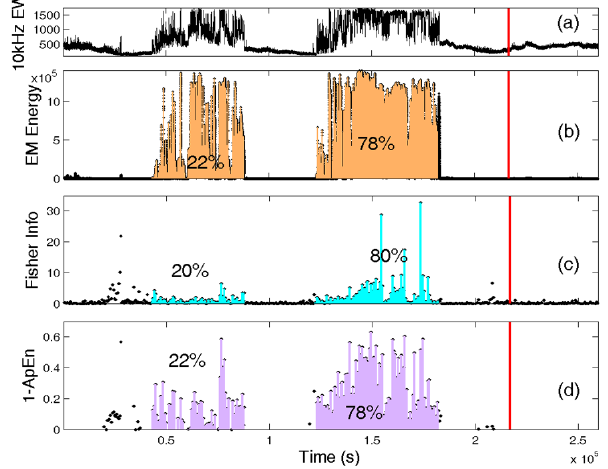
Fig. 2. (a) The two strong impulsive bursts in the tail of the recorded pre-seismic kHz EM emission prior to the Athens (Greece) EQ ( M = 5 . 9) that occurred on 7 September 1999 (please refer to Fig. 1 in Papadimitriou et al., 2008). For the specific signal excerpt, the EM energy (b) , the Fisher information (c) , and approximate en- tropy (d) evolutions with time are presented. The colored areas indi- cate the energy, information, and 1-ApEn corresponding to the two bursts. The first (left) burst is responsible for 22% of the EM en- ergy, 20% of the Fisher information, and 22% of the ApEn, while the second (right) for 78, 80, and 78%, respectively. All graphs are time aligned for direct reference. The time of the EQ occurrence is indicated by the thick vertical red line (Fig 1. in Potirakis et al.,